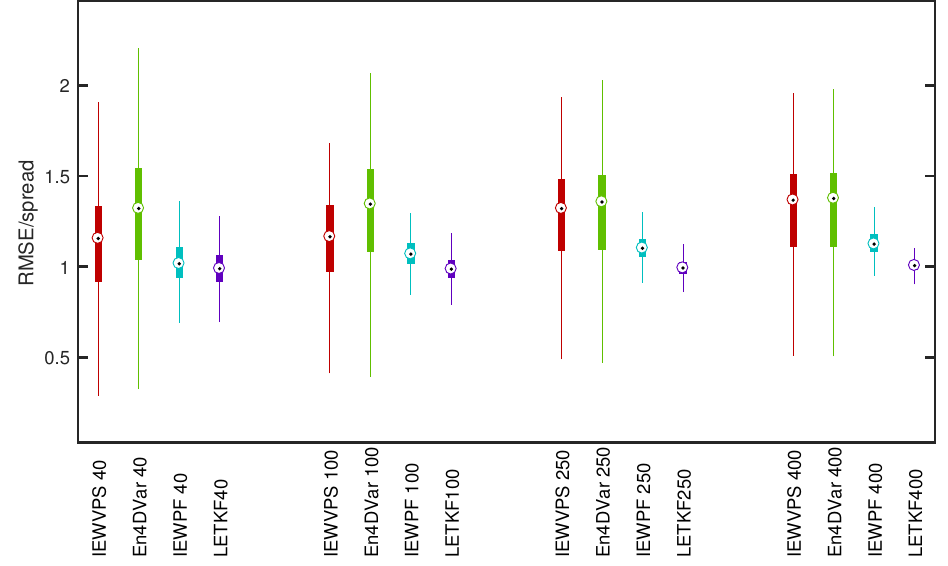
Figure 3. The ratio of the averaged posterior RMSE to ensemble spread for the different model dimensions. Red for the IEWVPS experiments; Green for the En4DVar experiments; Cyan for the IEWPF experiments, and Purple for the LETKF; the edges of the bar represent the minimum and maximum value, the filled box in the bar represents 99.3% data, and the cycle in bar represents the median value.